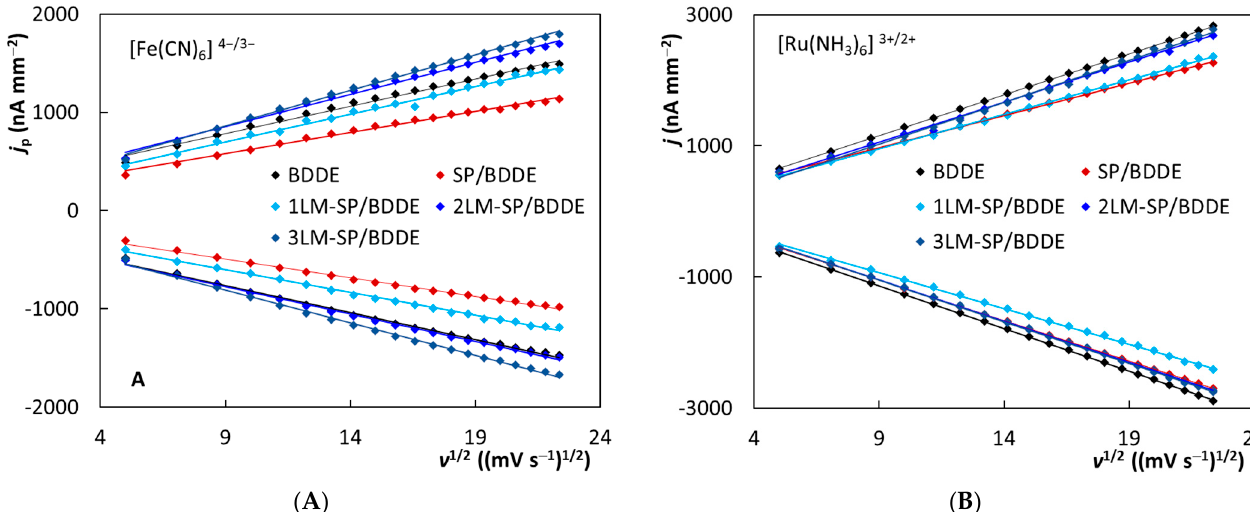
Figure 4. Dependences of current density ( j p ) on the square root of the scan rate ( v 1/2 ) obtained for [Fe(CN) 6 ] 4 − /3 − ( A ) and [Ru(NH 3 ) 6 ] 2+/3+ ( B ) using the tested sensors (electrolyte—0.1 mol L − 1 KCl, v = 25–500 mV s − 1 , c ([Fe(CN) 6 ] 4 − /3 − ) = 6.25 × 10 − 4 mol L − 1 , c ([Ru(NH 3 ) 6 ] 2+/3+ ) = 6.25 × 10 − 4 mol L − 1 ).